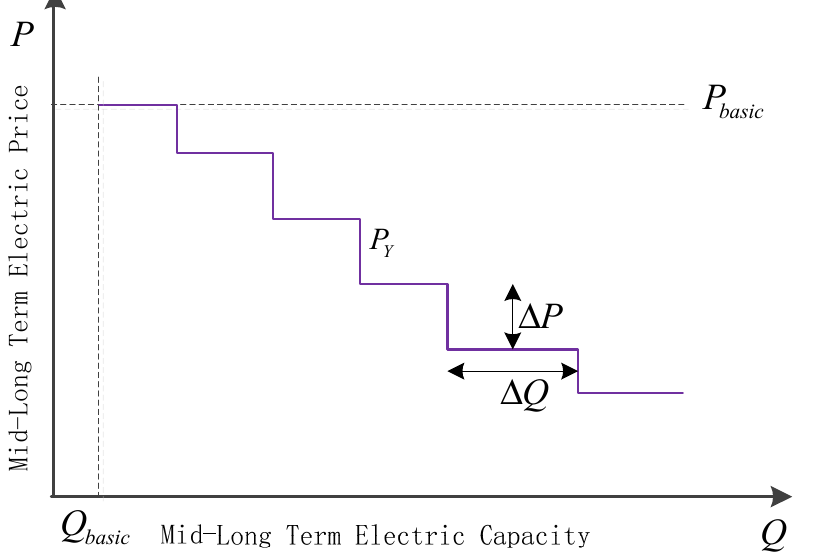
Figure 7. Relationship between electricity price and energy amount in medium-and-long term con- tracts.